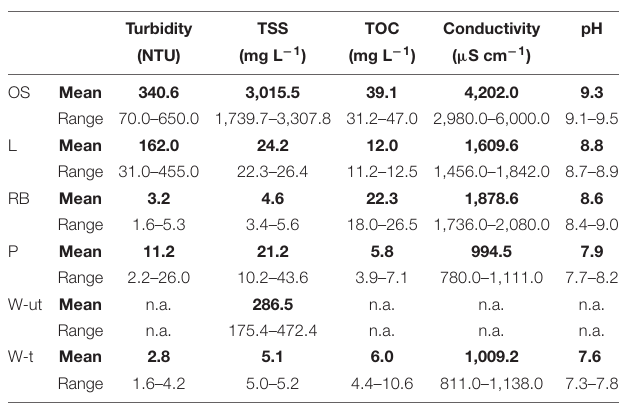
TABLE 1 | Chemo-physical parameters of environmental water samples from the six different sampling sites within the study